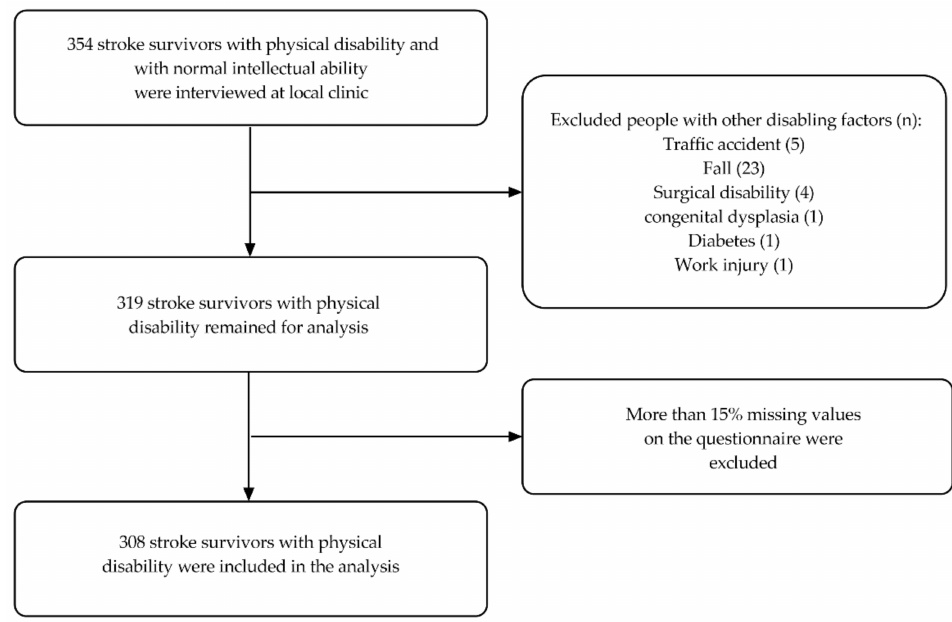
Figure 1. Inclusion and Exclusion